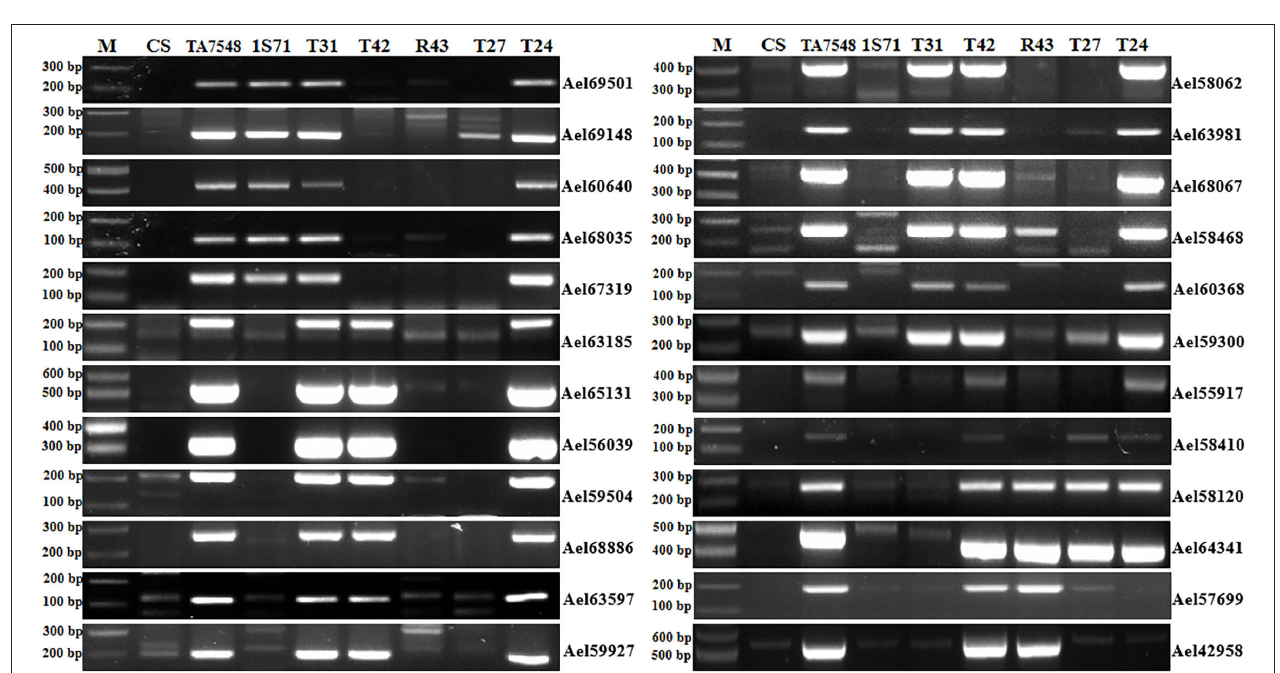
FIGURE 4 | PCR patterns of 6S l #3 recombinants using 6S l #3-specific markers. M: 100 bp DNA ladder marker.